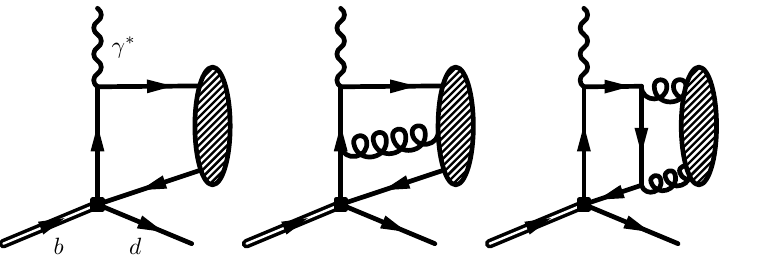
Figure 2 . Schematic representation of QCD condensates that appear in (cid:22) B